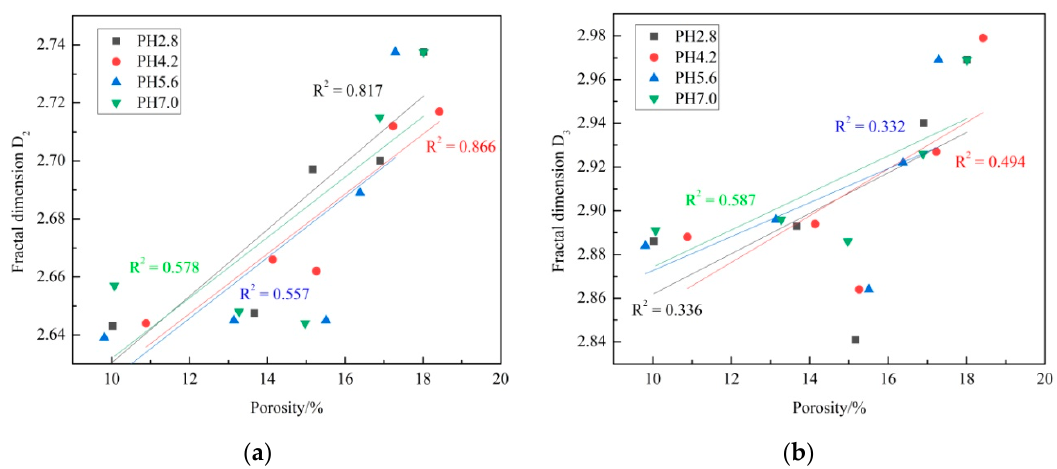
Figure 8. Correlation between porosity and segment fractal dimensions for sandstone immersed in different acidic solution: ( a ) fractal dimensions D 2 ; ( b ) fractal dimensions D 3 .